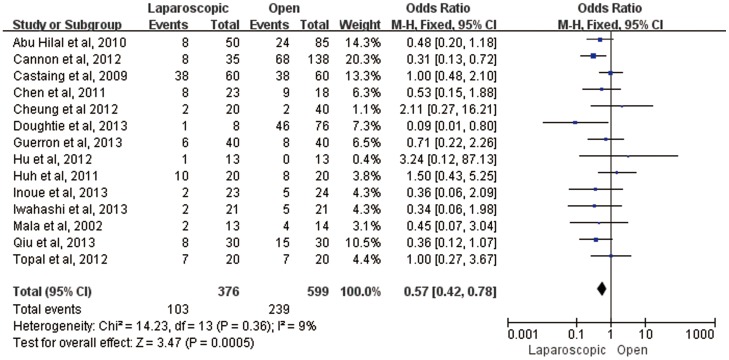
Forest plot of morbidity in all included studies.